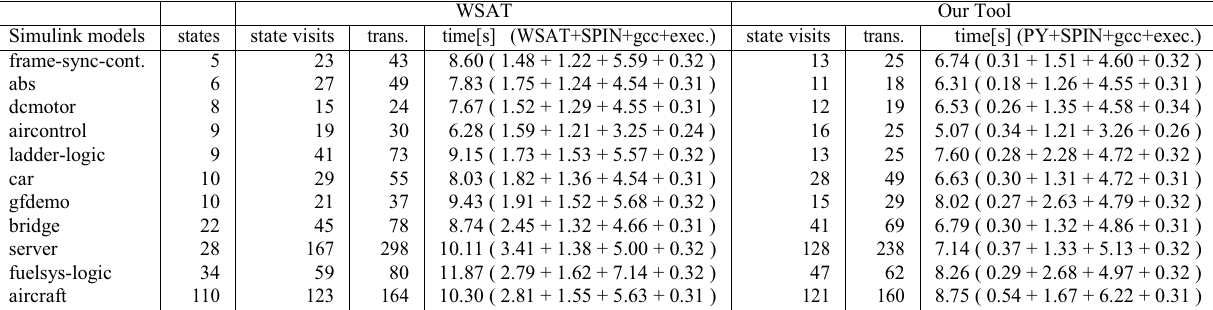
Table 2: Experimental results for checking liveness (deterministic) WSAT Our Tool Simulink models